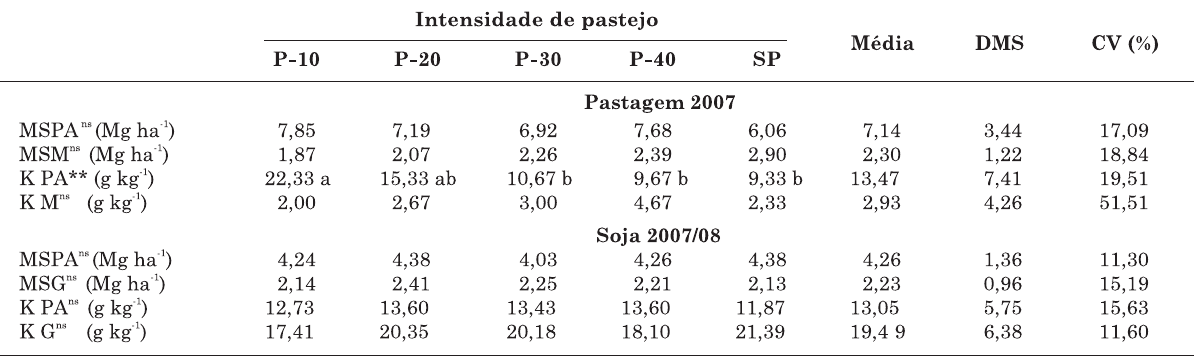
%.Quadro 1. Produção acumulada de matéria seca da parte aérea (MSPA) e do mantilho (1) (MSM) e teores